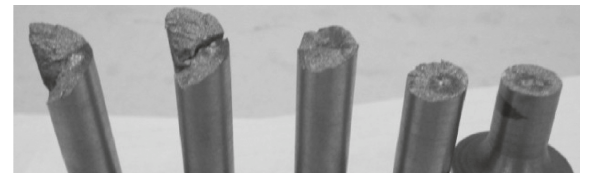
Figure 4: The macroscopic fracture surfaces of QT400-15 nodular cast iron in the tests of different stress states ranging from uniaxial tension to